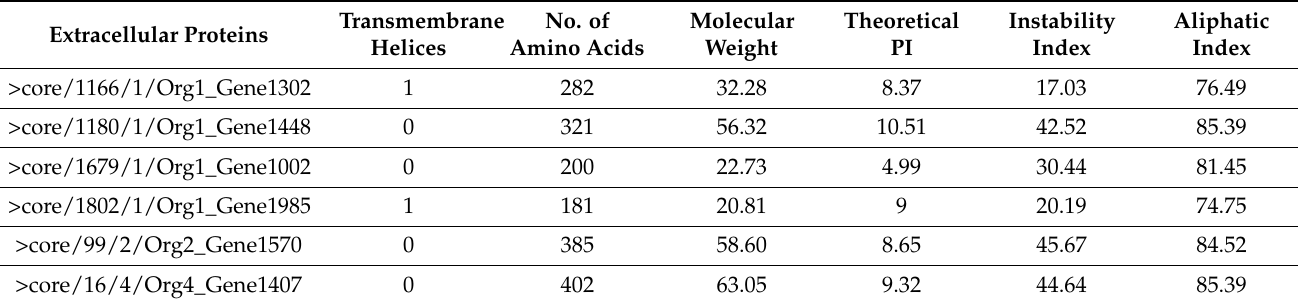
Table 4. Physiochemical properties and transmembrane helices analysis of selected